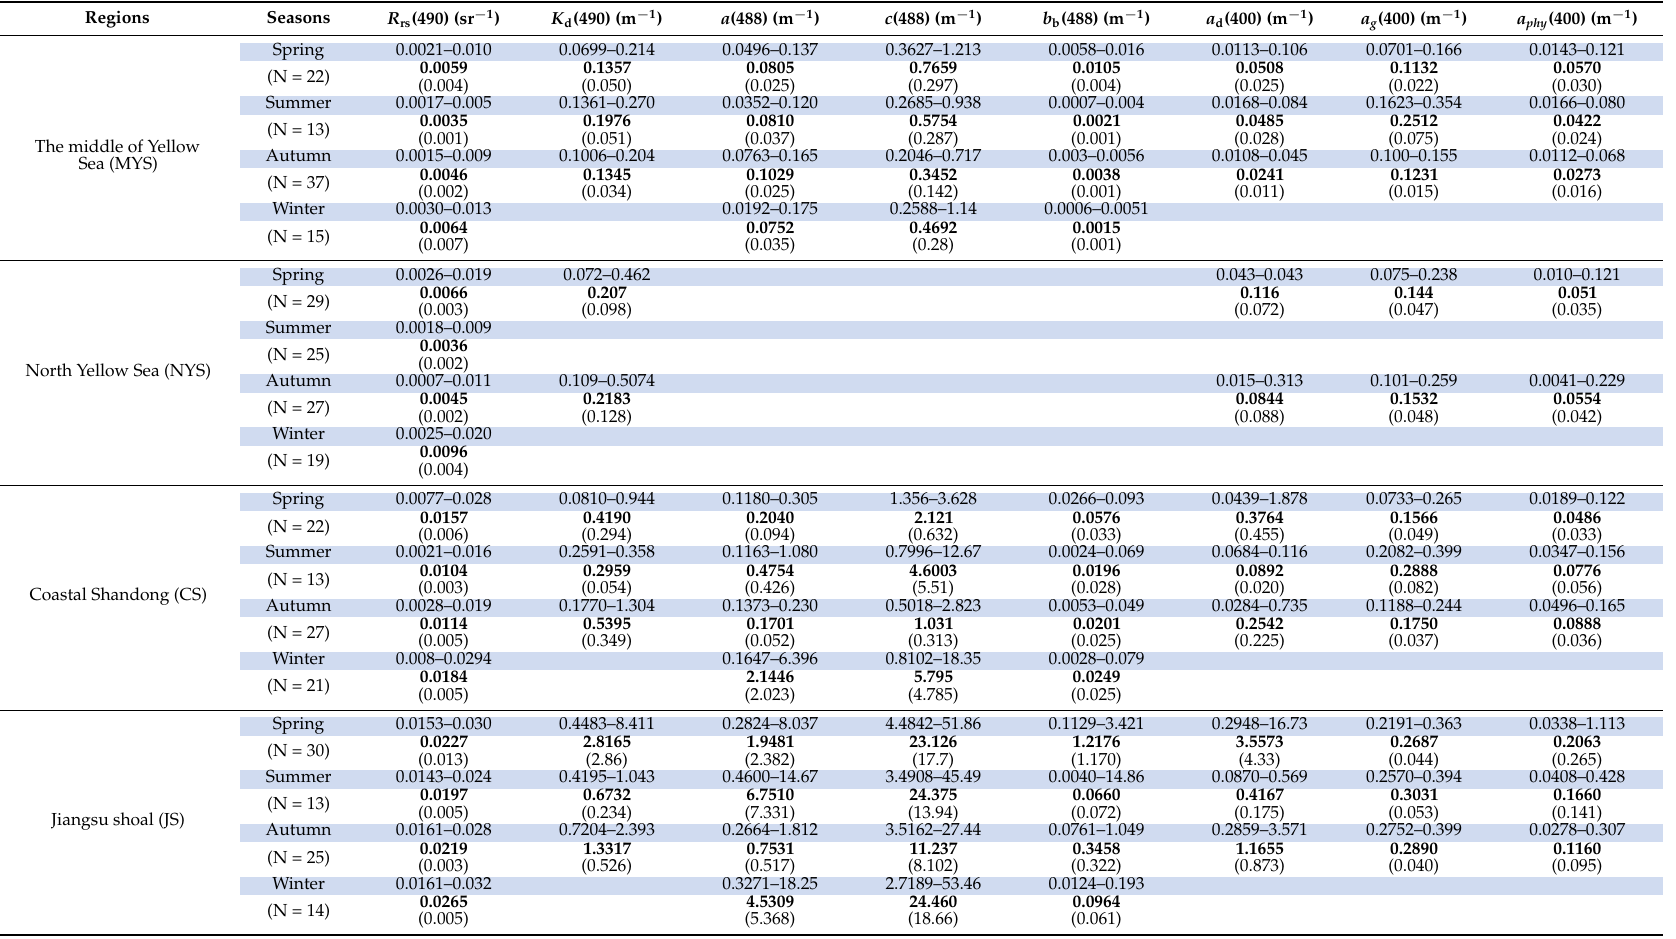
Table 2. Statistics for the in-situ data set values for coastal Shandong (CS), north Yellow Sea(NYS), the middle Yellow Sea (MYS), and Jiangsu shoal (JS) during spring, summer, autumn, and winter. Minimum and maximum values are linked with dashes, as in Min-Max; averages are shown in bold, with standard deviations in parentheses; N is the number of